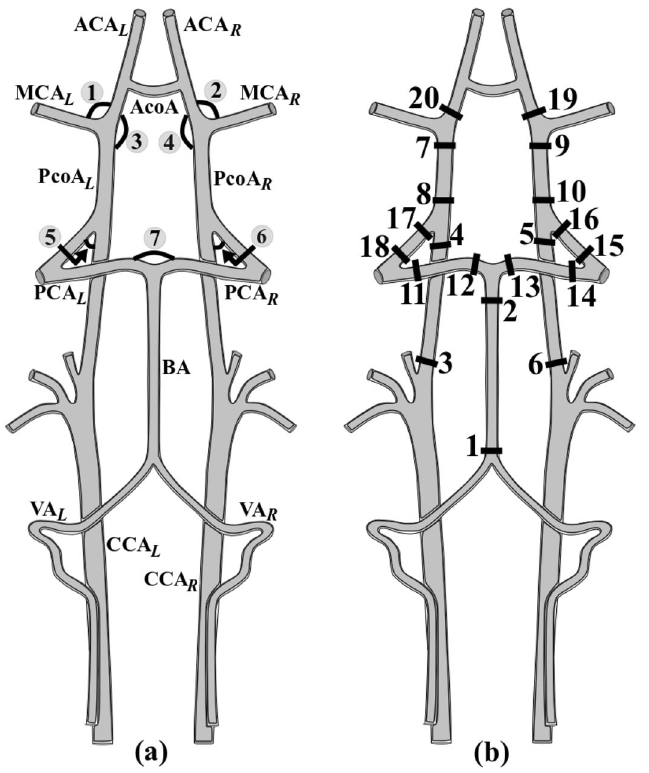
Figure 2. Anatomy of the mice circle of Willis (CoW). ( a ): The arteries are common carotid artery (CCA), vertebral artery (VA), basilar artery (BA), anterior cerebral artery (ACA), posterior cerebral artery (PCA), middle cerebral artery (MCA), posterior communicating artery (PcoA) and anterior communicating artery (AcoA). – L denotes left side, and − R—right side. 1 is the angle between ACA L and MCA L , 2 is the angle between ACA R and MCA R , 3—the angle between ACA L and PcoA L , 4—the angle between ACA R and PcoA R , 5—the angle between ICA L and PcoA L , 6—the angle between ICA R and PcoA R , 7—the angle between PCA L and PCA R . ( b ): The cross-sectional